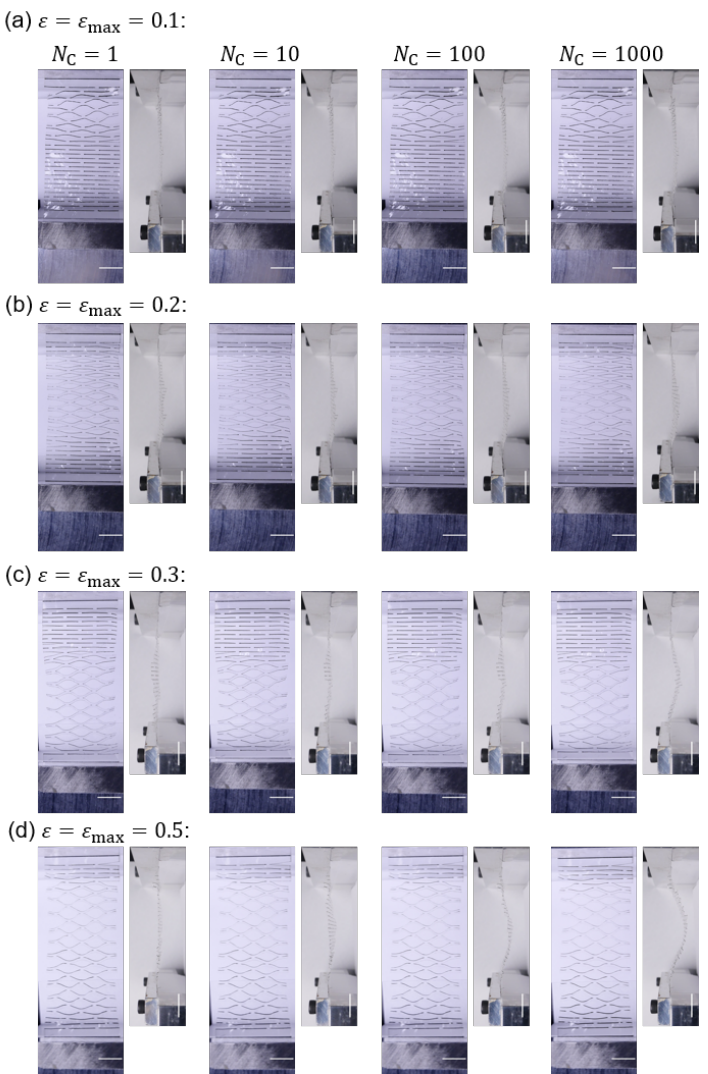
Figure 3. Sequential snapshots in the iterative tensile loading cycles of specimens with s = 3 for different maximum strains ε max . Four sets of subfigures in each of ( a – d ) show the number N c = 1,10,100, and 1000 of tensile loading cycles, respectively—from left to right. A unit pair of subfigures for a specific N c indicate the top and side views of the specimen. It should be noted that top views correspond to the state of ε max whereas the side views correspond to the original end-to-end distance state. The scale bars indicate 10